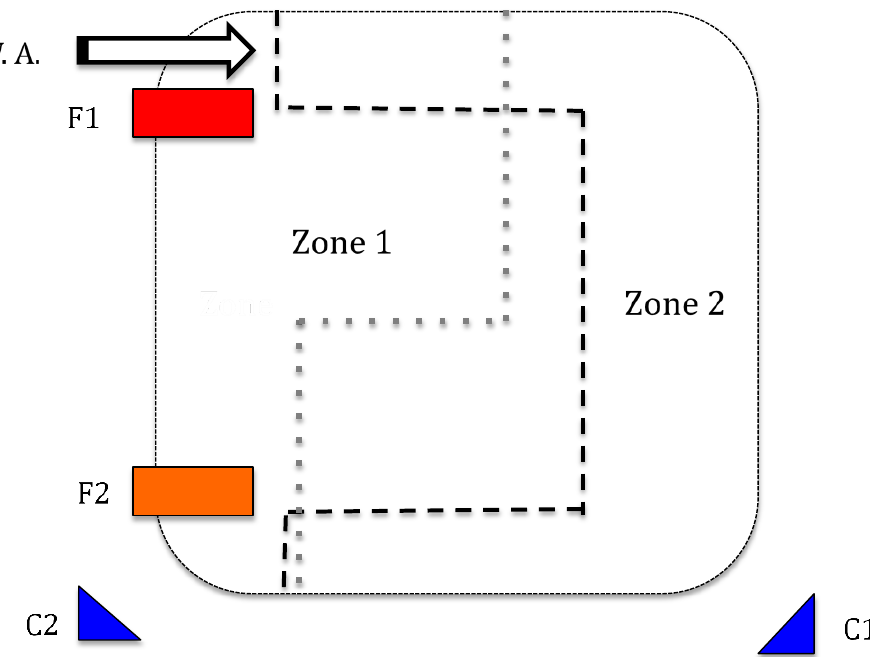
Figure 2. Top view showing part of the tank with the physical enrichment (PVC planks and pipes) and feeders that were covered by the field of the video cameras. C1 and C2 indicate the position of the video cameras. The dotted line indicated the parts, which are visually accessible by the cameras in zones 1 and 2, respectively. Zone 1 = the low light intensity zone (5 lux); Zone 2 = the high light intensity zone (20 lux); W.A. = water arrival; F1, F2 = automatic feeders.